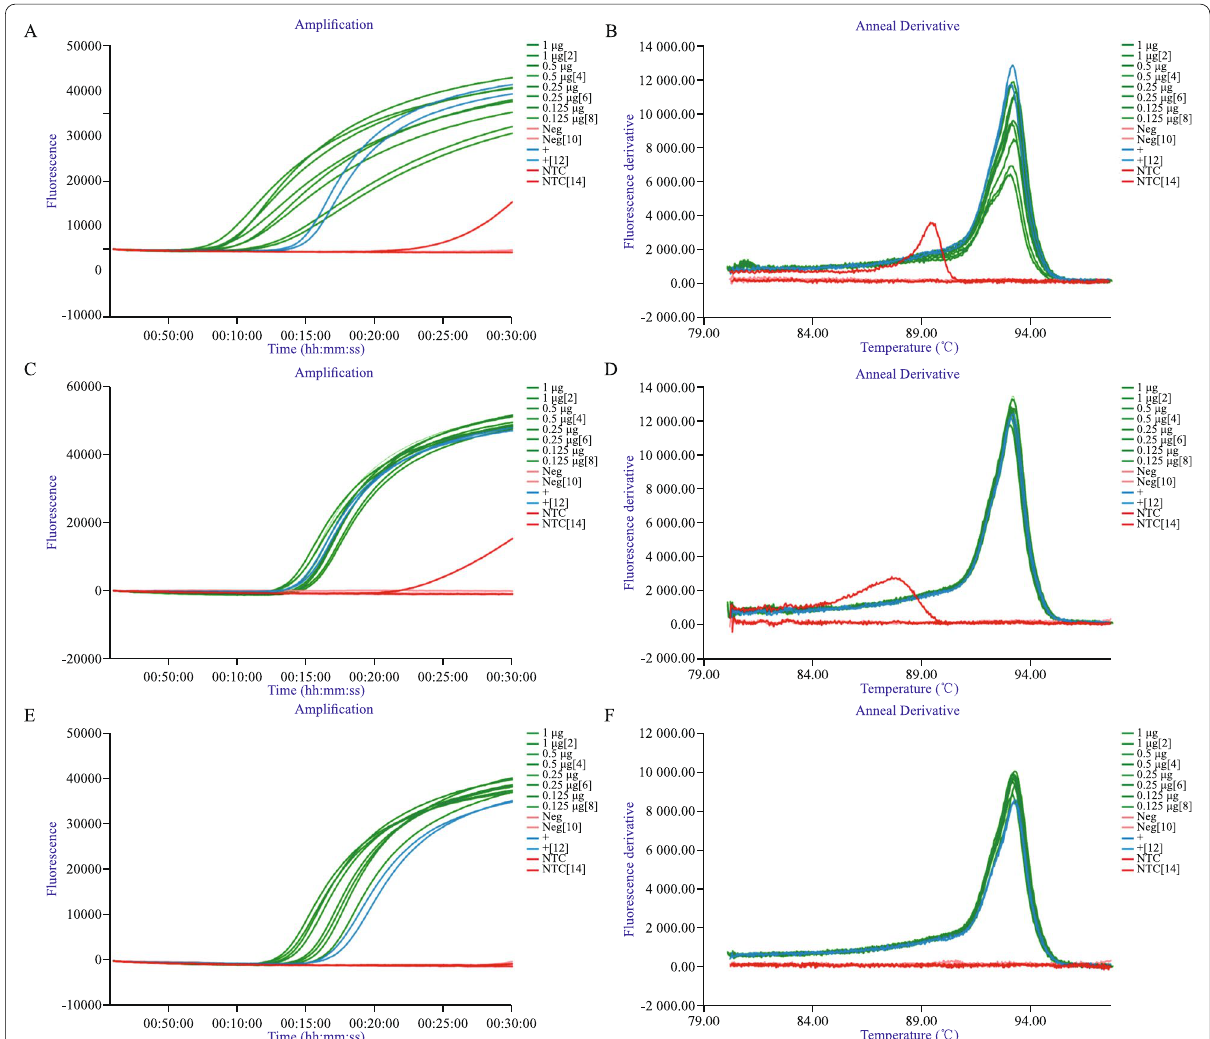
Fig. 2 AtLAMP performed on different Austropeplea tomentosa water environmental DNA isolation methods. LAMP amplification curves for AtLAMP performed on range spiked A. tomentosa DNA amounts purified by ethanol precipitation and silica dioxide purification ( A ), 50 mL by filtration ( C ) and 250 mL by filtration ( E ). The fluorescent derivative annealing curve for the corresponding ethanol precipitation and silica dioxide purification ( B ), 50 mL by filtration ( D ) and 250 mL by filtration ( F )